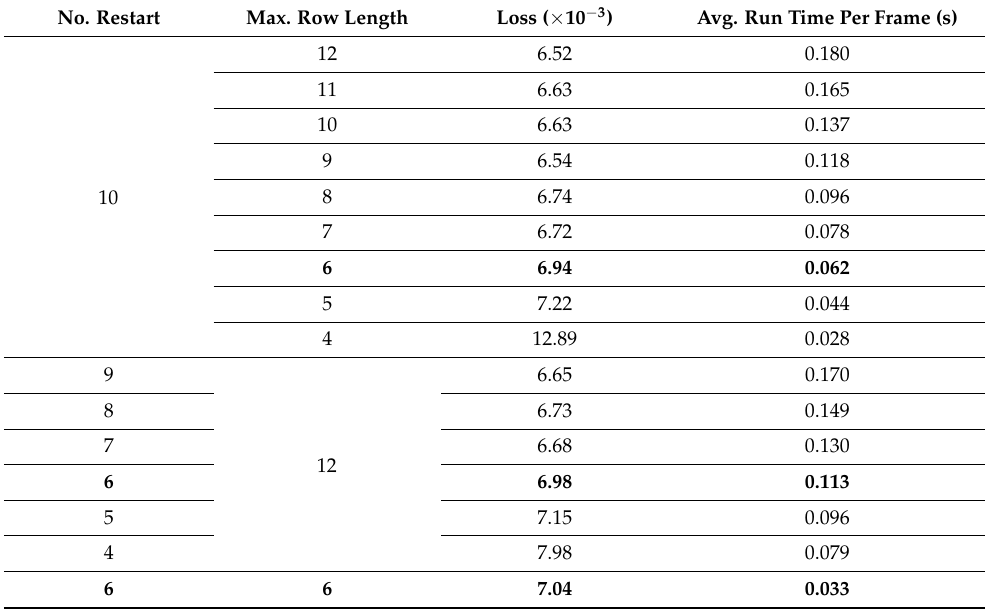
Table 3. Comparison of uDEAS run time measured in NUC (bold: optimal